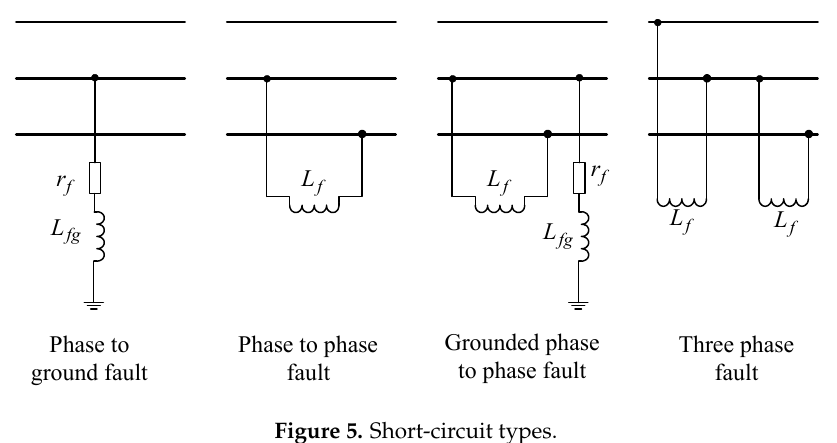
Figure 5. Short-circuit types.